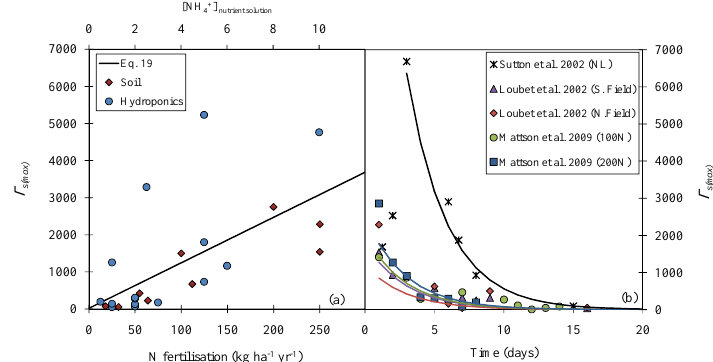
Fig. 6. (a) Compiled maximal stomatal ammonia emission potential ( 0 s ( max ) ) for managed ecosystem types (i) the first day after fertilisation (red diamonds) as a function of applied fertilisation rate (primary x-axis) or (ii) grown in hydroponics (blue circles) as a function of [NH + ] 4 concentration in the nutritive solution (secondary x axis). The line is the best fit linear function derived by minimisation of the least square method for the two series (hydroponics and soil). One mM of NH + in the nutritive solution was approximated to be equal to 22kgNha − 1 . 4 (b) Dynamics of 0 s in the days following N fertiliser application (symbols) and adjusted functions (curved lines) according to Eq.